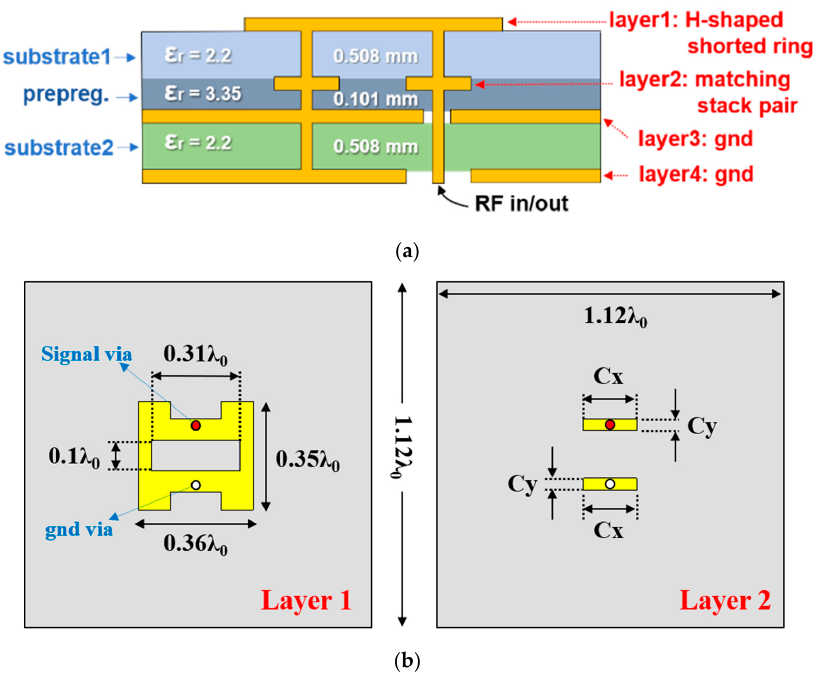
Figure 2. Proposed antenna structure with ( a ) multi-layer information and ( b ) layer 1 and layer 2.